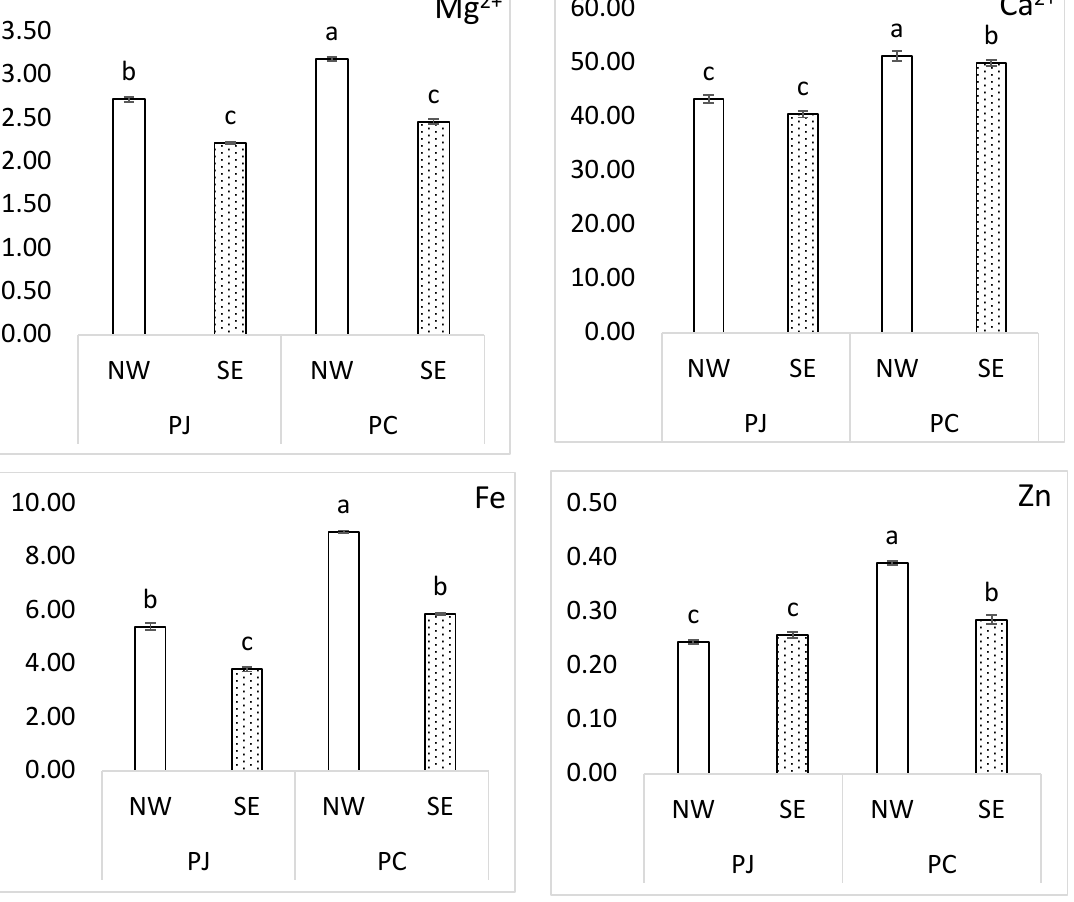
Means with the same letter (small or capital) are not significantly different from each other ( p > 0.05; ANOVA followed by Duncan multiple range test). Error lines represent means ± S.E. of 3 replicates.